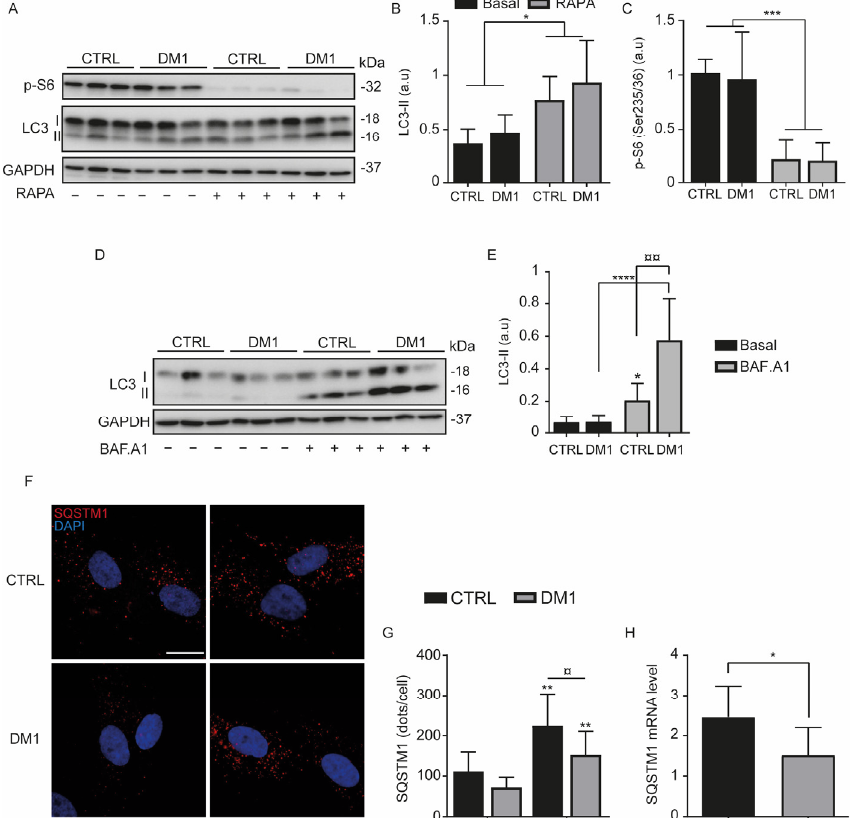
Figure 1. Autophagy flux is induced in myotonic dystrophy type 1 (DM1). ( A – E ) CTRL and DM1 cells were treated with 1 µM rapamycin (RAPA) or 100 nM bafilomycin A1 (BAF.A1) for 2 h. Expression levels of LC3-II ( A , B , D , E ) and p-S6(Ser235/236) ( A , C ) were assessed by immunoblotting and their densitometry was normalized to the loading control, GAPDH. Data are the mean ± SD of two replicates (* p < 0.05, *** p < 0.001, **** p < 0.0001 versus untreated cells, ¤¤ p < 0.01 versus BAF.A1-treated CTRL cells, with two-way ANOVA-Tukey’s test), arbitrary units (a.u). Each group (CTRL or DM1) consisted of three cell lines. ( F , G ) CTRL and DM1 cells were treated with BAF.A1 for 4 h. ( F ) Cells were immunolabeled with SQSTM1 antibody (Red) and nuclei stained with DAPI (blue), scale bar represents 10 µm. The original magnification is ×60. G/Quantification of SQSTM1 dots per cell was determined using ImageJ software ( n = 100 cells/condition). Data are the mean ± SD of two replicates (** p < 0.01 versus untreated cells and ¤ p < 0.05 versus BAF.A1-treated CTRL cells, with two-way ANOVA-Tukey’s test). ( H ) Represents the SQSTM1 mRNA expression level determined by qPCR. Data are the mean ± SD of two replicates (* p < 0.05 respect to CTRL cells). Each group (CTRL or DM1) consisted of three cell lines. All experiments were performed at least three times.